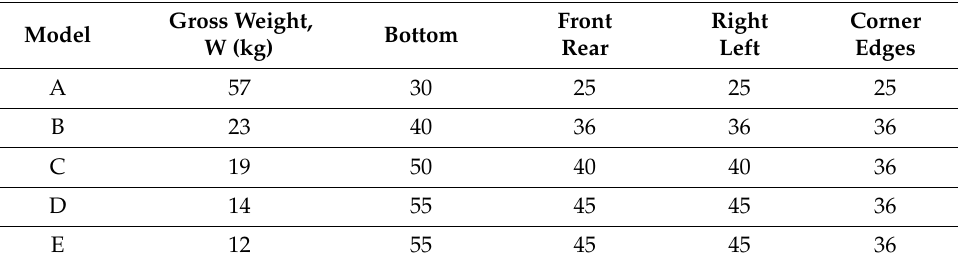
Figure 3. Molded EPS packaging design models.